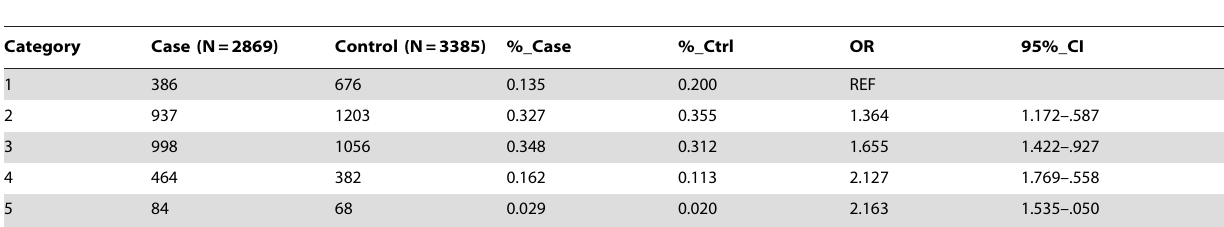
Table 4. wGRS using 5 significant associated SNPs evaluated on independent validation sample